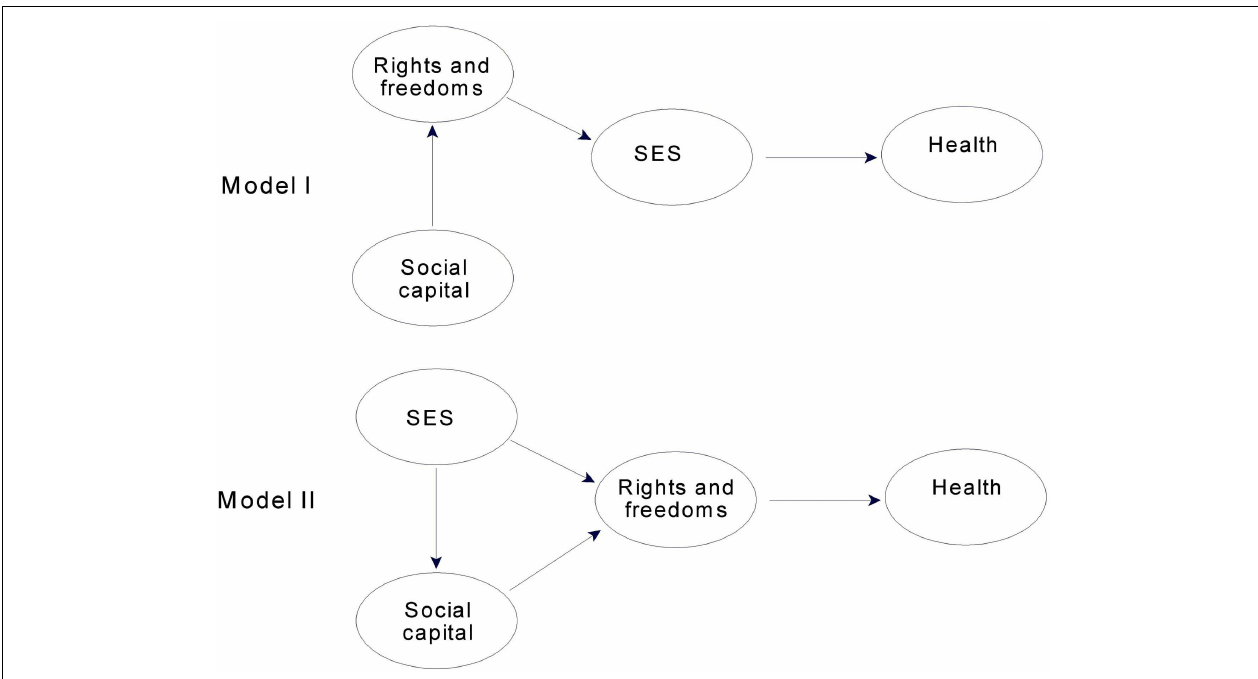
FIGURE 2 | Contrasting conceptual path models for evaluating direct and mediated effects for SES, and rights and freedoms for the 23 countries that had social capital data. Models for the full sample omitted the latent construct for social capital.